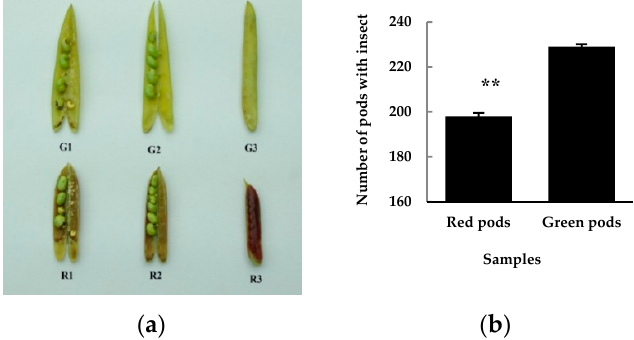
Figure 5. The insect feeding 30-day-old green ( top ) and red ( bottom ) pods after anthesis ( a ), and their insect feeding rates ( b ). The samples in A are: G1, R1: insect feeding pods; G2, R2: normal pods (inside) and G3, R3: normal pods (intact). The value in B is the average of three biological duplicate samples.